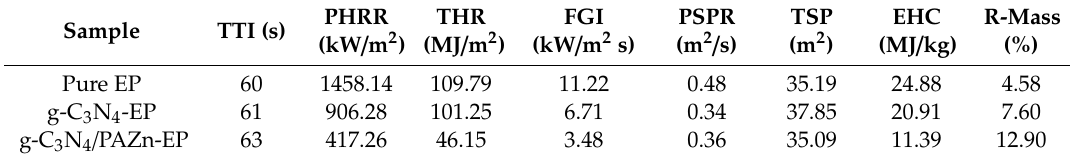
Table 2. Combustion index obtained from a cone calorimeter test